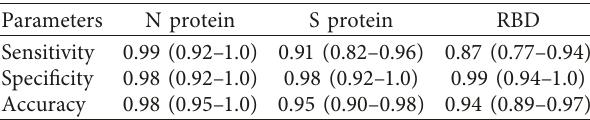
Figure 2: ELISA performed with different severe acute respiratory syndrome (SARS-CoV-2) proteins used as antigens. (a–c) IgG anti- SARS-CoV-2 detected by ELISA using N (a), S (b), and RBD (c) antigens. The cutoff was set as the mean plus two standard deviations of the healthy control samples. The correlations of the ELISA values between N and S (d), N and RBD (e), and S and RBD (f) antibody values. The Pearson correlation coefficient (r) was used to measure the strength of the correlation between the ELISA results performed with different antigens. The results are from one experiment of the three experiments performed. Table 1: The overall diagnostic performance of enzyme-linked immunoassay (ELISA) performed with the N protein, S protein, and receptor binding domain (RBD) fraction as